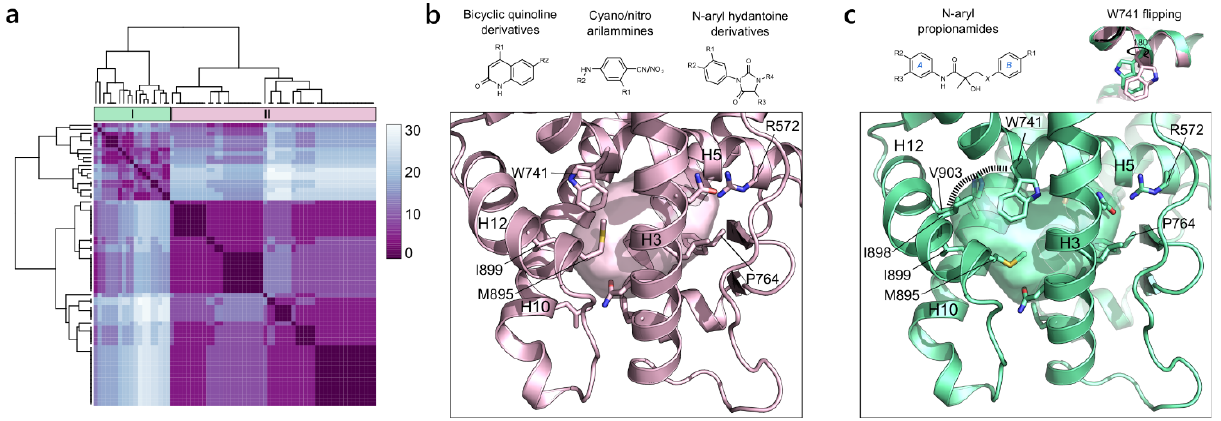
Figure 4. AR variability. ( a ) Heatmap of the hierarchical clustering of AR. ( b ) On the bottom, the representation of the pocket from cluster II (PDB ID 1T63) is shown and on top, the general chemical structures of the binding compounds are shown. ( c ) On the bottom, the representation of the pocket in cluster I (PDB ID 3B67) is shown. On the top, the chemical structure of the N-aryl propionamide compounds and the flipping of W741 responsible for the extension of the binding site in the WT form of AR are shown.